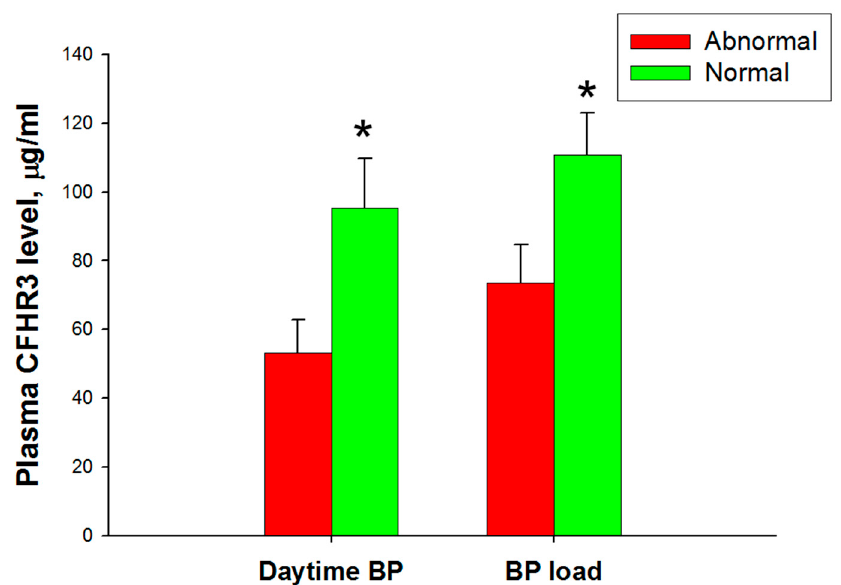
Figure 1. Plasma CFHR3 level in children with non-CAKUT CKD when subgrouped to an abnormal ABPM profile in daytime BP (left) and BP load (right). * p < 0.05 vs. abnormal ABPM by the Mann–Whitney U-test.